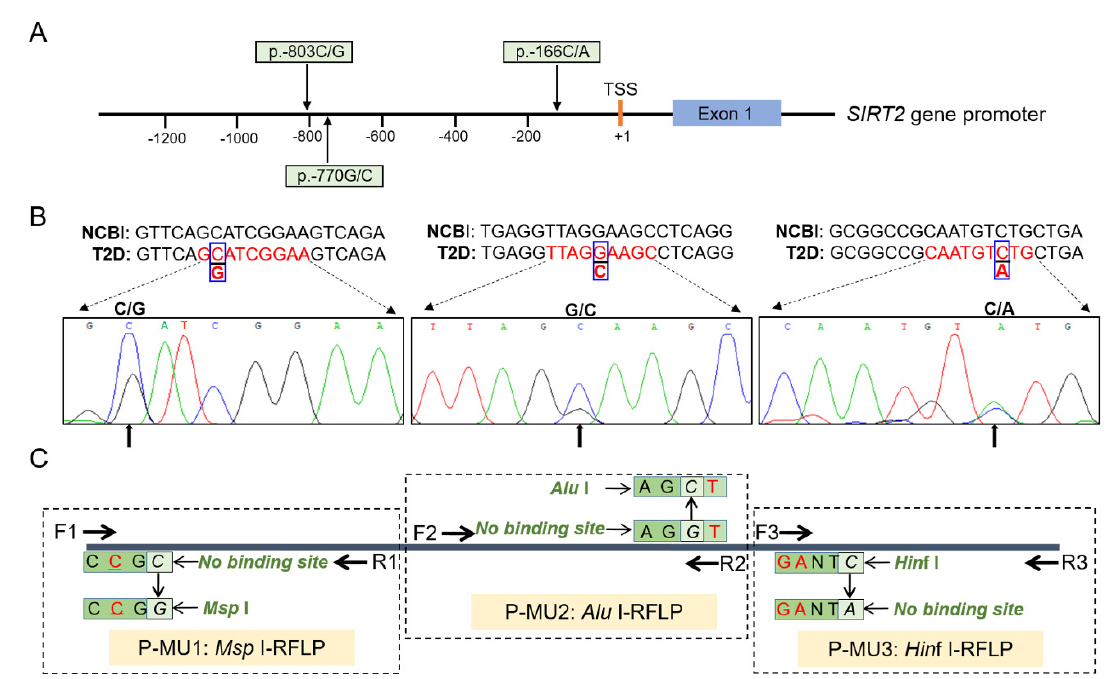
Figure 1. Discovery and genotyping of three SNPs in the SIRT2 promoter region. ( A ) Location of the three novel SNPs found in our study. ( B ) Sequencing maps of the three SNPs. ( C ) Schematic diagram of genotyping the P-MU1, P-MU2, and P-MU3 loci by Msp I-RFLP, Alu I-RFLP, and Hin f I-RFLP, respectively.